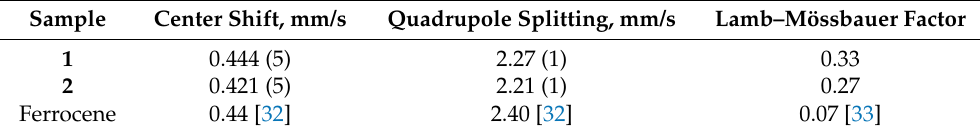
Table 1. Room temperature 57 Fe hyperfine parameters.